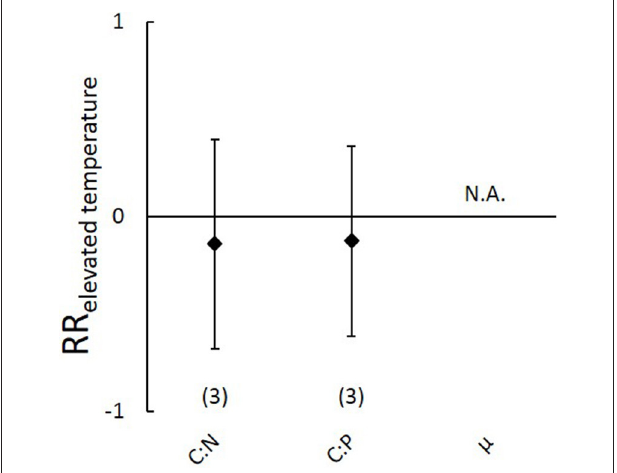
FIGURE 4 | Natural-log response ratios of aboveground carbon:nutrient stoichiometry and plant growth rates ( µ ) to 3-6 degrees elevated temperature from the meta-analysis on submerged aquatic plants. Values represent means, error bars 95% confidence intervals and sample size is indicated between brackets. No response ratios were significantly different from zero. N.A., indicates that data were not